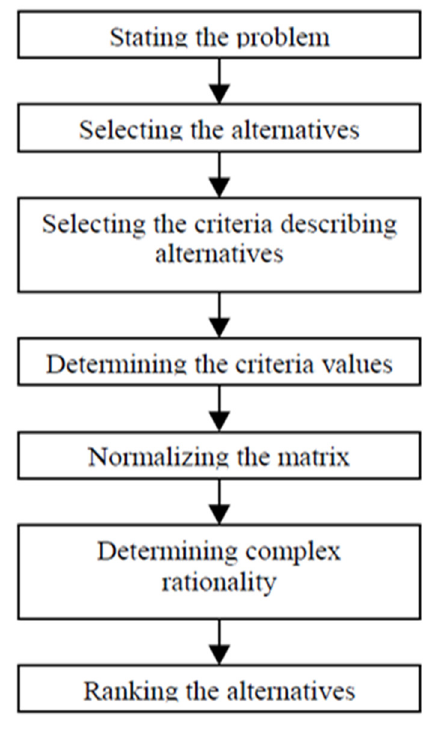
Fig. 2. Flowchart of (MOORA) approach .